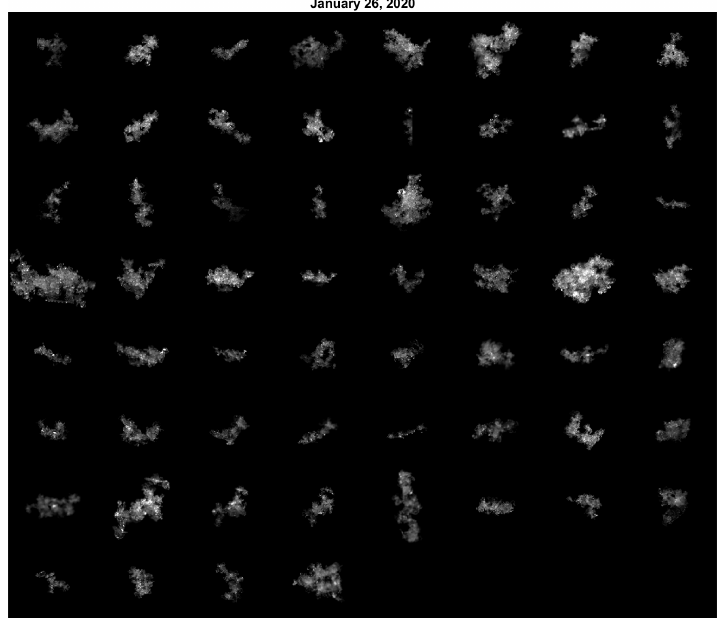
Figure C3. MASC snowflake imagery for 26 January 2020.